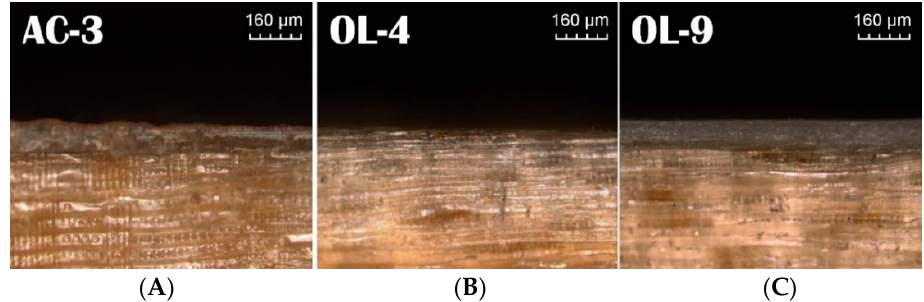
Figure 1. Images from confocal laser scanning microscope showing a typical film of thick acrylate coating (( A ) AC-3 in this case), penetrating oils (( B ) OL-4 in this case) and oil-based coatings also creating a surface layer (( C ) OL-9 in this case) after application. It is possible to see only very poor penetration into the first layer of tracheids in the impermeable larch heartwood.